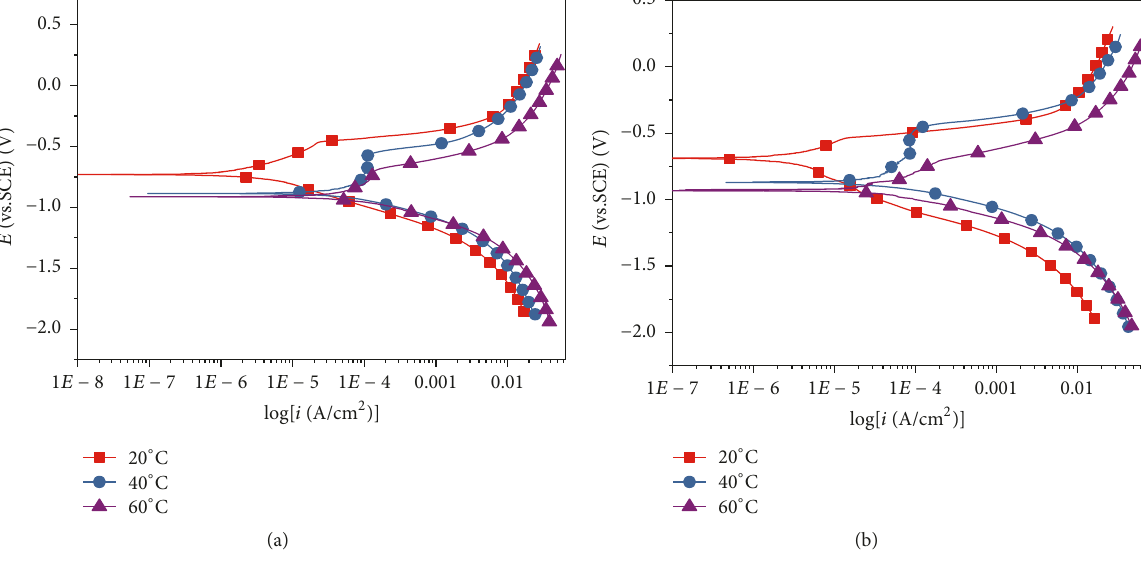
Figure 9: Influence of temperature on the polarization curve of (a) BM and (b) WM. Table 5: Fitted results of EIS in the Korla soil simulated